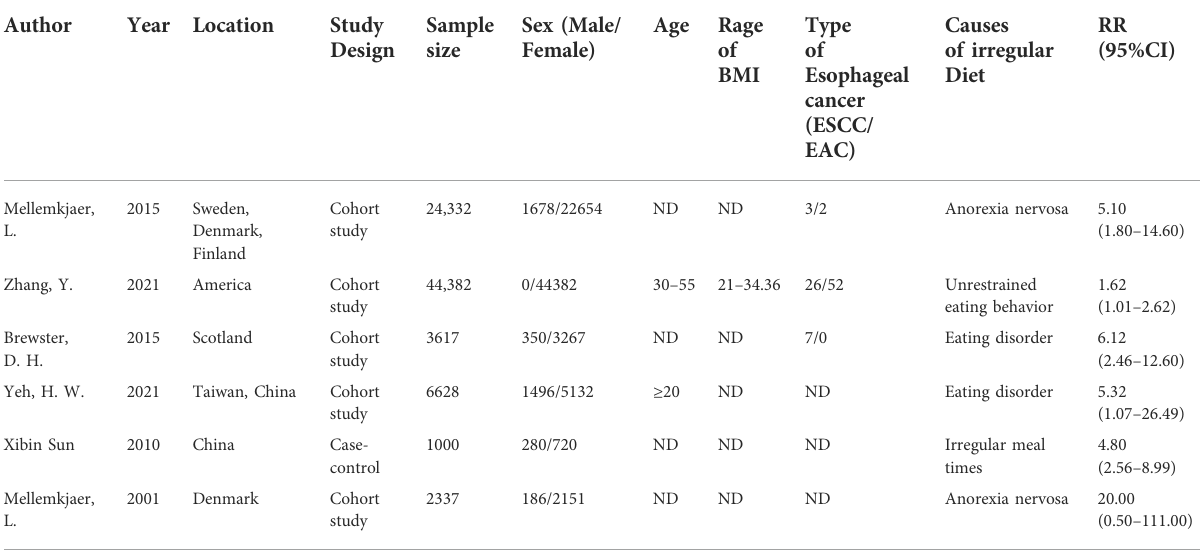
TABLE 1 Basic characteristics of the studies included in the